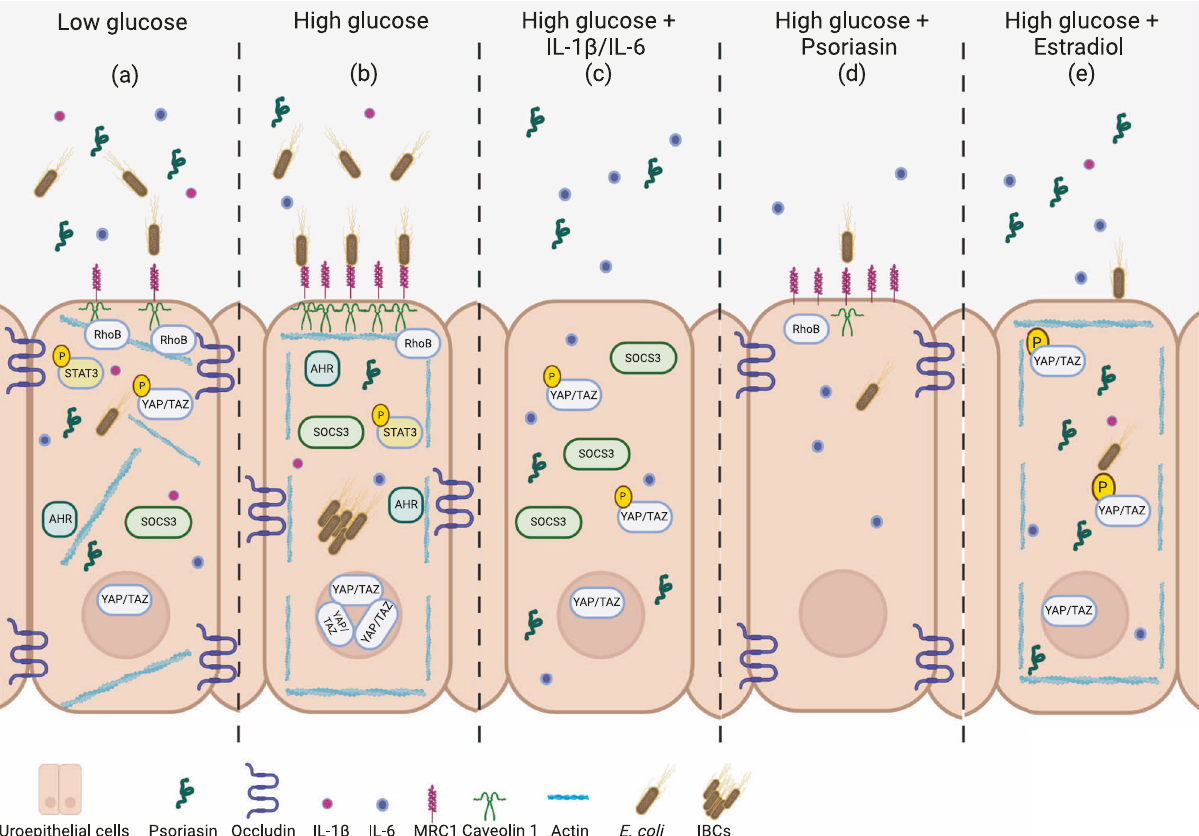
Fig.7|Schematicrepresentationofaltereduroepithelialimmuneresponsesin high glucose. The impact of high glucose on uroepithelial cells, and the effects of psoriasin, IL-1 β , IL-6 and estradiol on the background of high glucose exposed uroepithelial cells is demonstrated in the current study. Immunological changes occurring due to high glucose in comparison to a low glucose condition. b High glucose signi fi cantly downregulates psoriasin, IL-1 β , IL-6, occludin, SOCS3 and RhoB without altering the pSTAT-3 level, but upregulates the expression of AHR, caveolin 1 with increased nuclear YAP/TAZ and cortical actin leading to increased